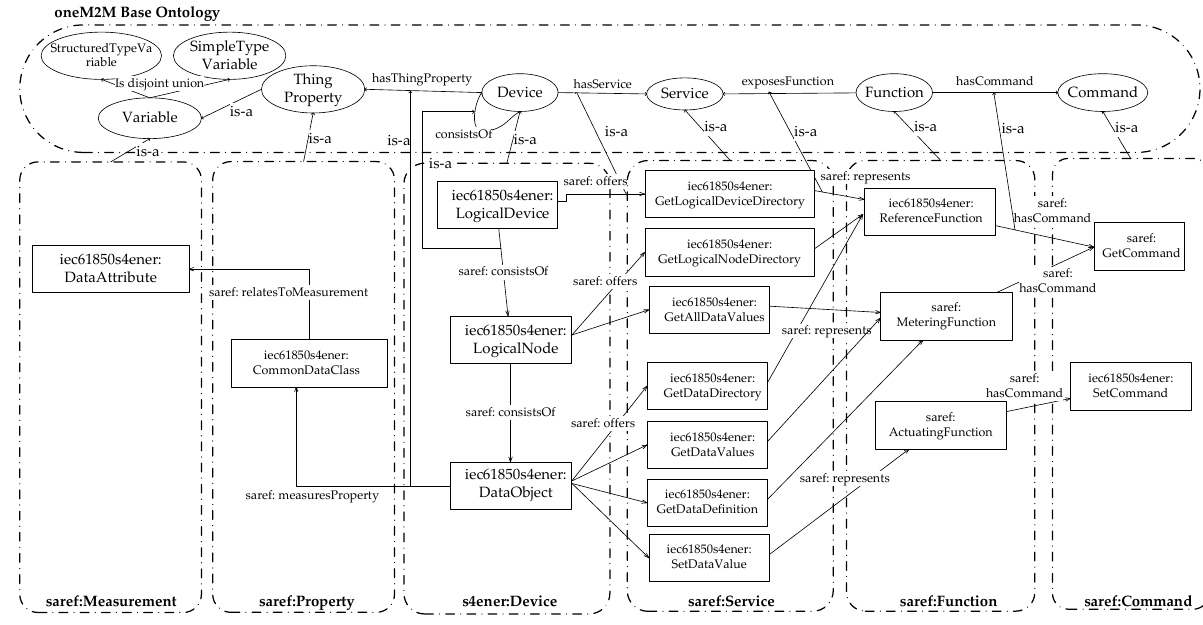
Figure 12. Common Ontology between IEC61850 ‐ SARF4ENER and oneM2M Base